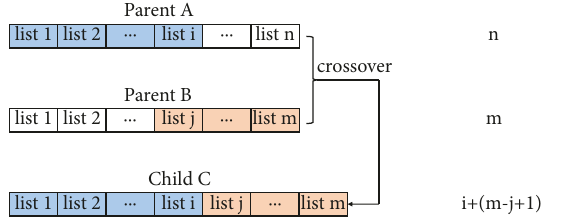
Figure 9: Schematic diagram of crossover of ECNN.